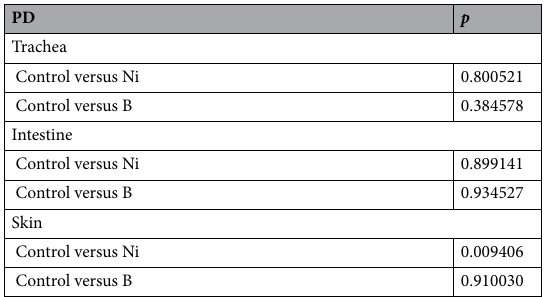
Table 7. Results of the Mann–Whitney test ( p < 0.05) for transepithelial electric potential measured during stationary conditions (PD) for the tissue specimens. Control—specimens incubated in the bumetanide (0.1 mM) solution, Ni—specimens incubated in the nickel chloride (0.1 mM) and bumetanide (0.1 mM) solution, PD—transepithelial potential difference of the tissue surface (mV) measured in stationary condition at the beginning of experiments.